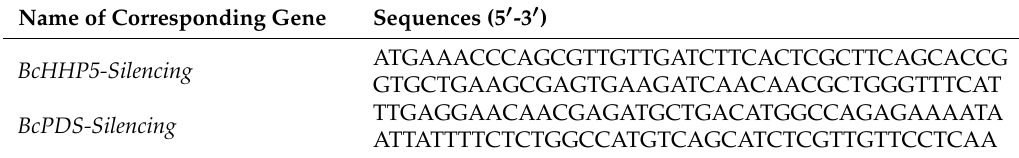
Table 3. Sequences for virus-induced gene silencing test